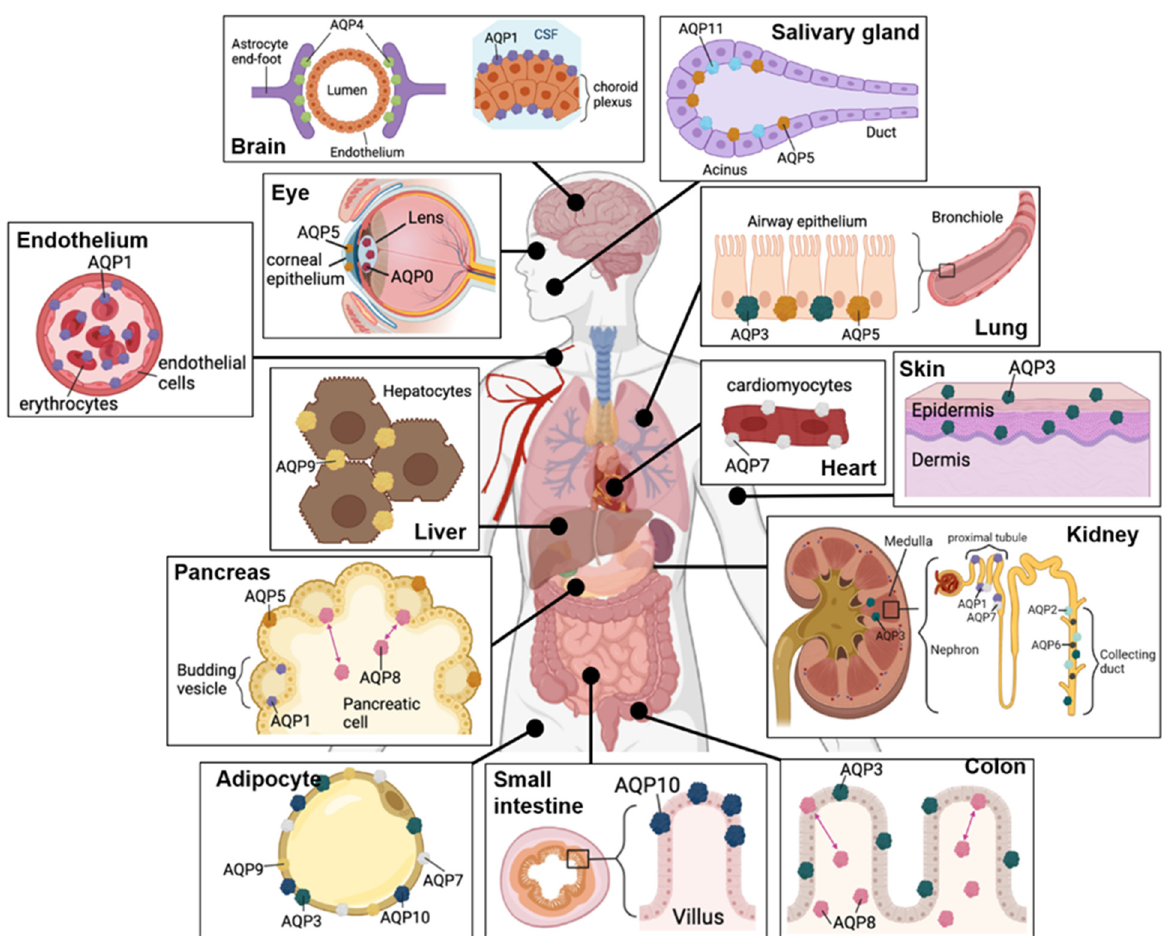
Figure 1. Overview of mammalian aquaporin tissue distributions. In the brain, AQP1 is abundant in the choroid plexus, and AQP4 is high in astrocyte end-feet. AQP1 is the predominant aquaporin in erythrocytes and blood vessel endothelial cells. AQP5 and AQP11 are expressed in the salivary glands. In the eye, AQP5 is expressed in the epithelial cells of the cornea, and AQP0 in the lens. AQPs 3 and − 5 are expressed in the epithelium of the respiratory tract. Hepatocytes, cardiomyocytes and epidermal keratinocytes express AQPs 9, − 7 and − 3, respectively. In pancreatic cells, AQPs 1 and − 5 are expressed on the membrane; AQP8 shuttles between intracellular and membrane locations. In the kidney, AQP3 is expressed in the medulla and collecting ducts; AQPs 1 and − 7 are colocalized in the proximal tubule; AQPs 2 and − 6 are expressed in the apical membranes of the collecting ducts. Adipocytes express aquaglyceroporins AQPs − 3, − 7, − 9, and − 10. AQP10 is highly expressed in intestinal villi. AQP3 and AQP8 are abundant in colonic tissue.